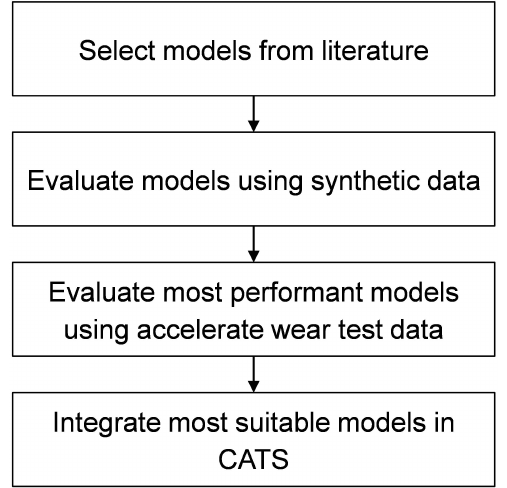
Figure 3. Overview of the model evaluation